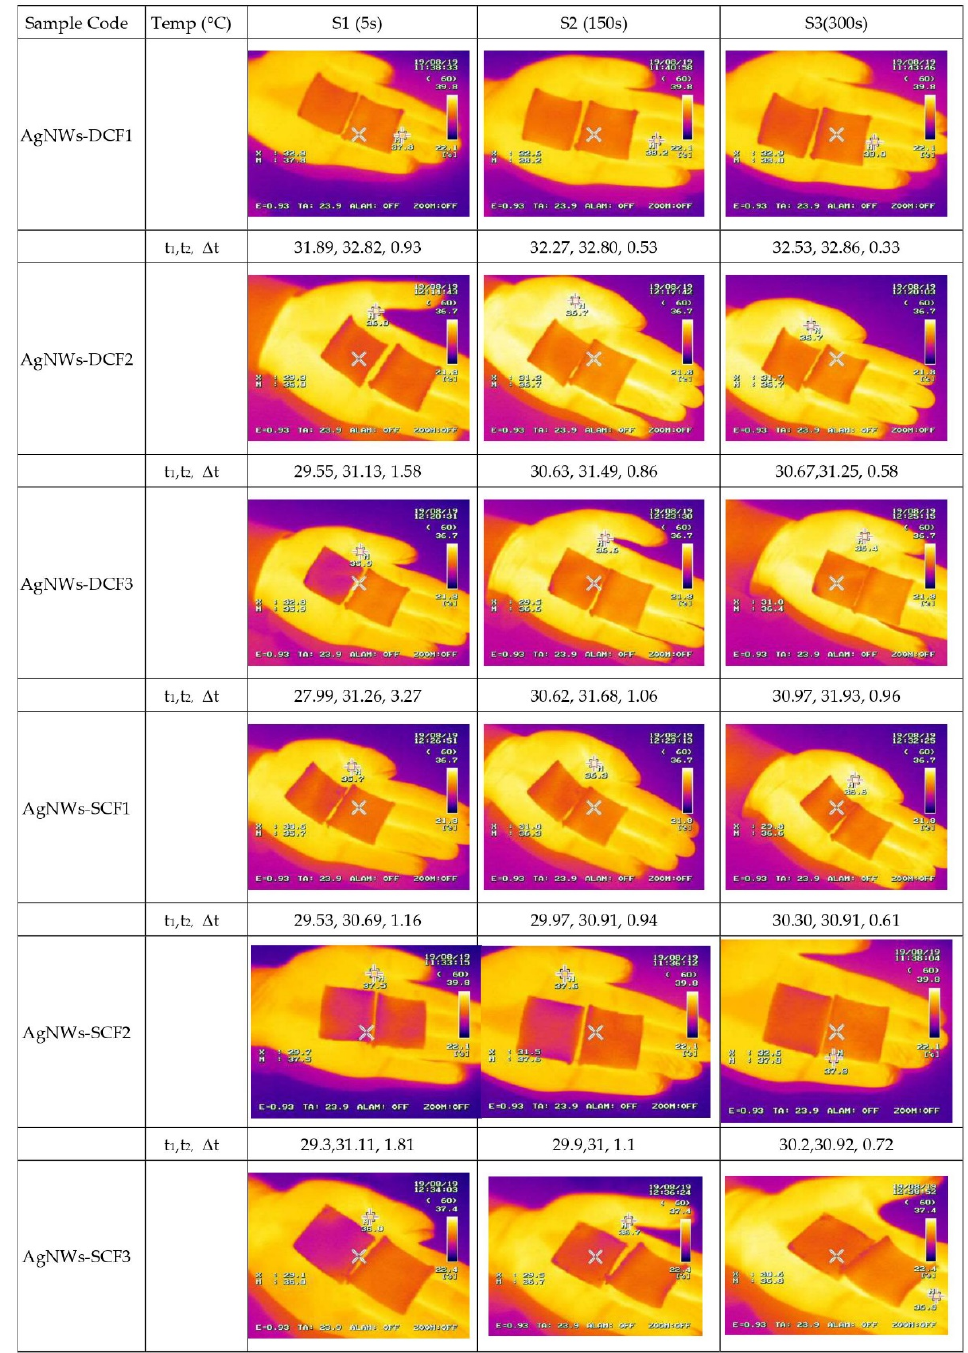
Figure 3. Thermal camera results of samples measured at different time intervals (~5 s, ~150 s, and ~300 s). In the left column, the sample number, mean temperature of coated samples, and mean temperature of the blank sample are presented for variable time intervals.